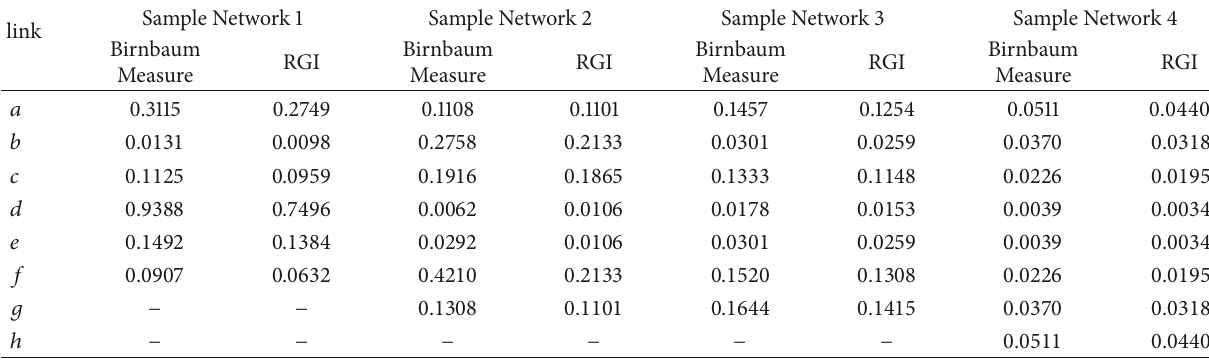
Table 1: Birnbaum measure and risk growth factor RGI.